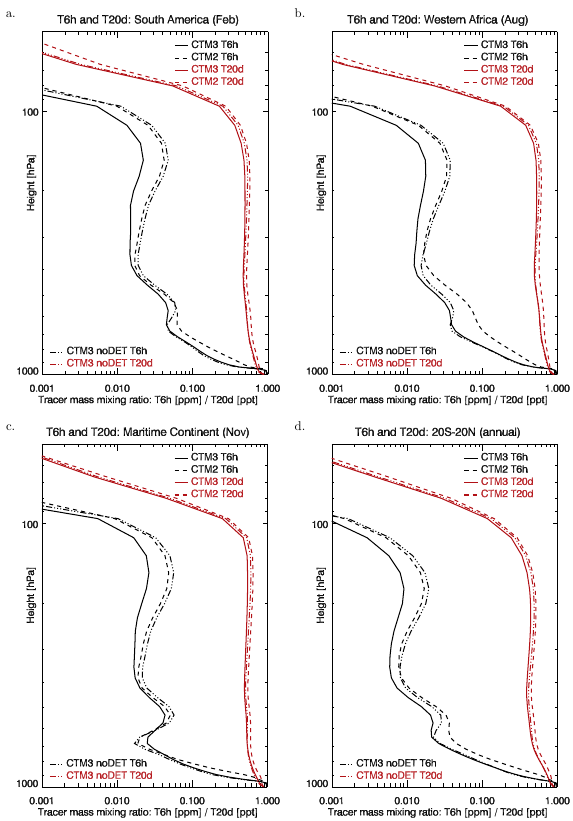
Fig. 9. T6h (ppm) and T20d (ppt) tracer as described in text and by Hoyle et al. (2011): selected monthly means for regions and annual mean for 20 ◦ S–20 ◦